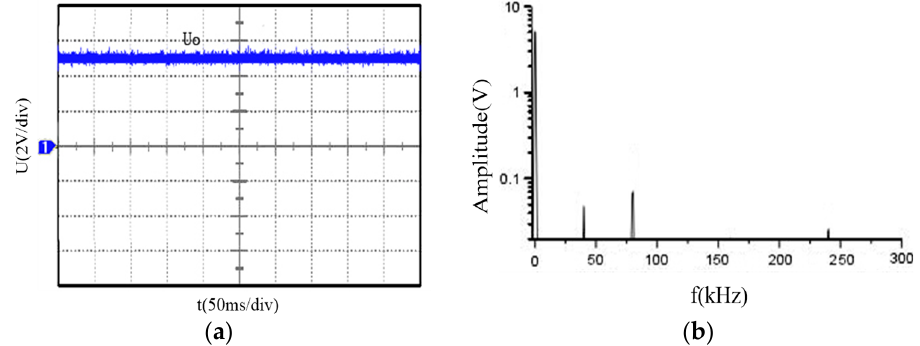
Figure 15. The experiment voltage waves of the DC power generation: ( a ) Output voltage wave; ( b ) output voltage spectrum.